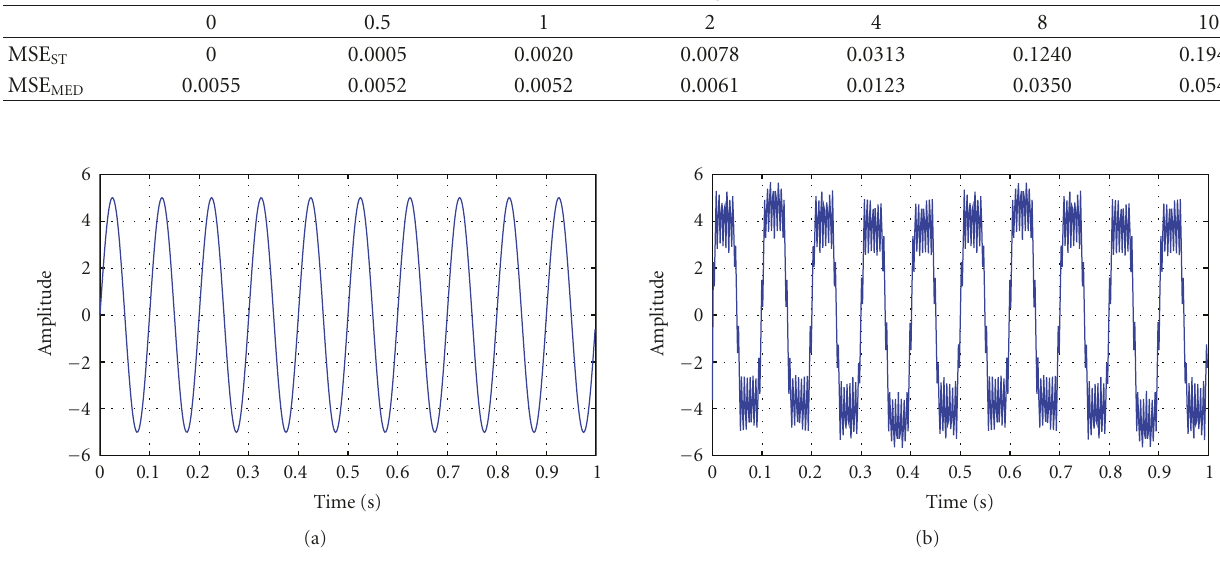
Figure 4: Example of distortions introduced by ATM method of RDFT: the noise-free harmonic signal ( F = 10Hz) (a) and its estimate obtained using inverse DFT of (cid:2) S ATM ( p )